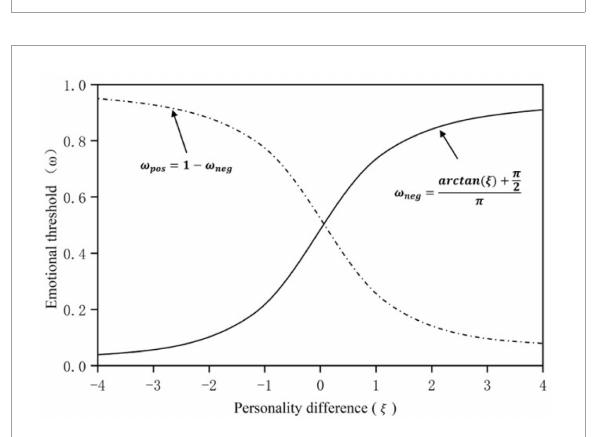
FIGURE5 Simulation image of emotional threshold